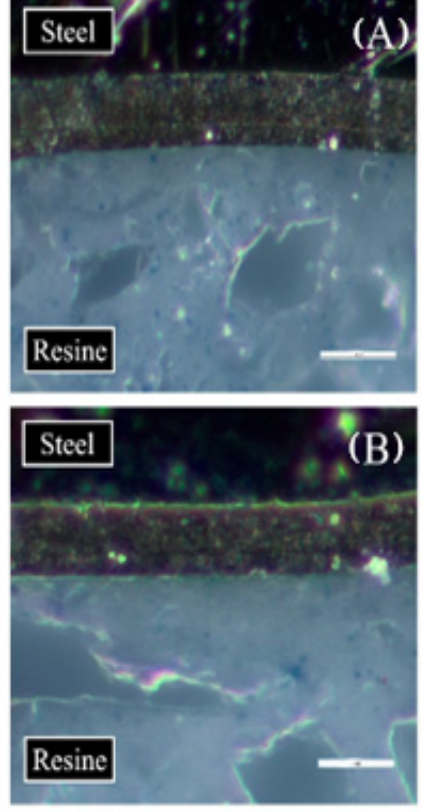
Figure 5. Cross-sections of hybrid Zn/CuO ( A ) and Zn/NCs ( B ) coatings. Scale bar is 10 μ m.